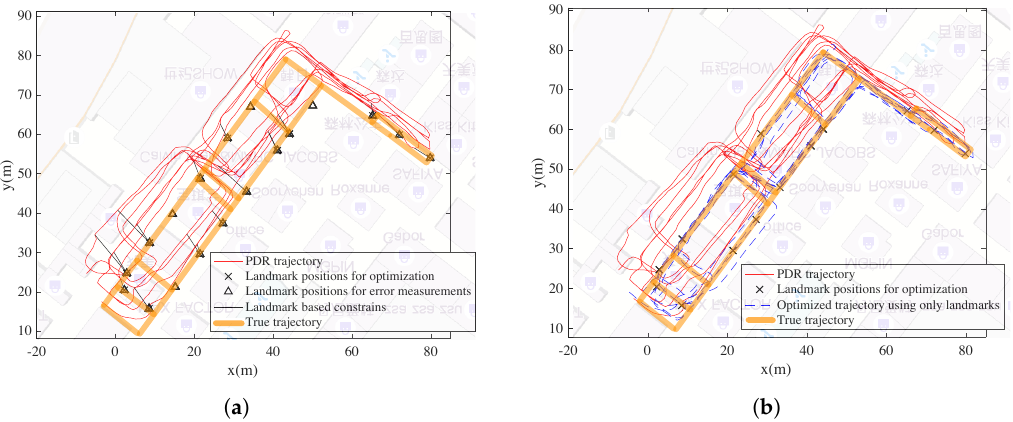
Figure 9. Results for fusing PDR trajectory and landmark positions. ( a ) Landmark based constraints. ( b ) Optimized trajectory using landmark